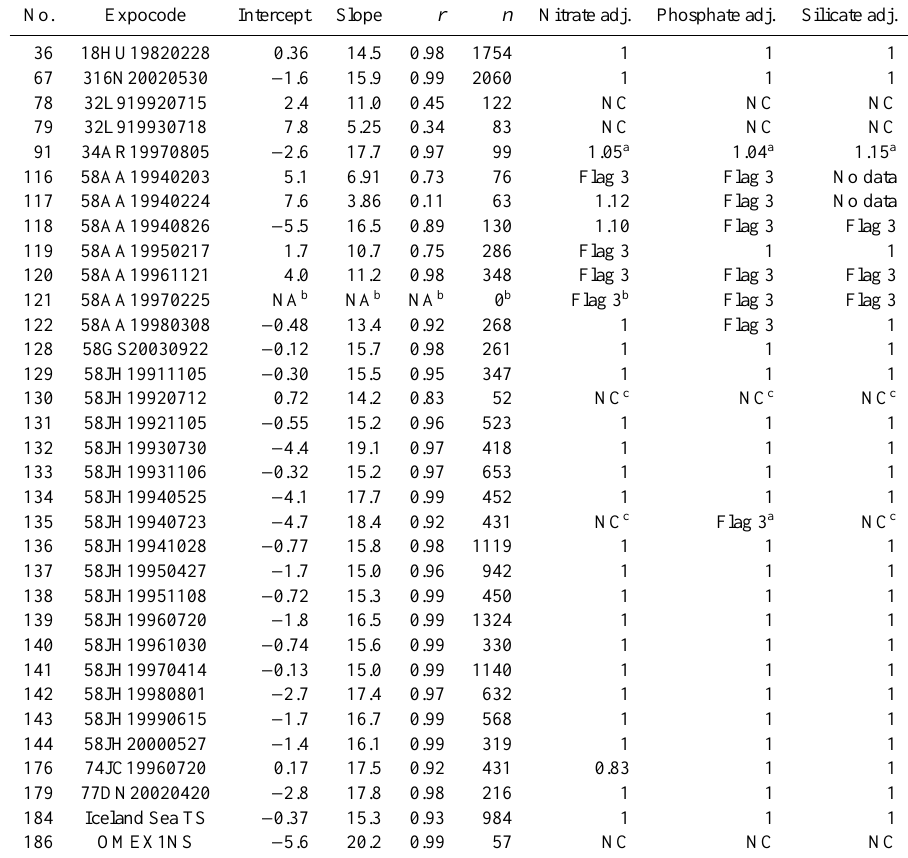
Table 1. CARINA cruises with nutrient data from the Nordic Seas, P-N regression coe ffi cients and recommended multiplicative adjustments for the nutrients.